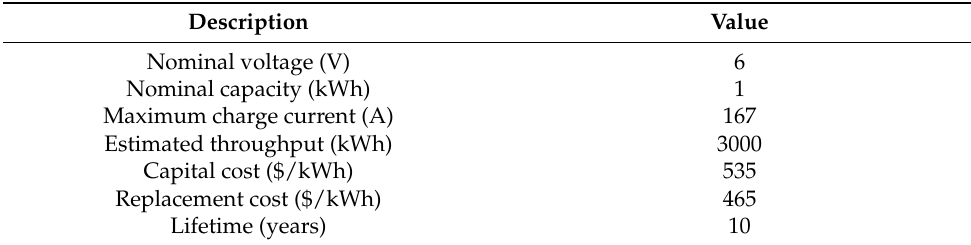
Table 3. Technical details of the